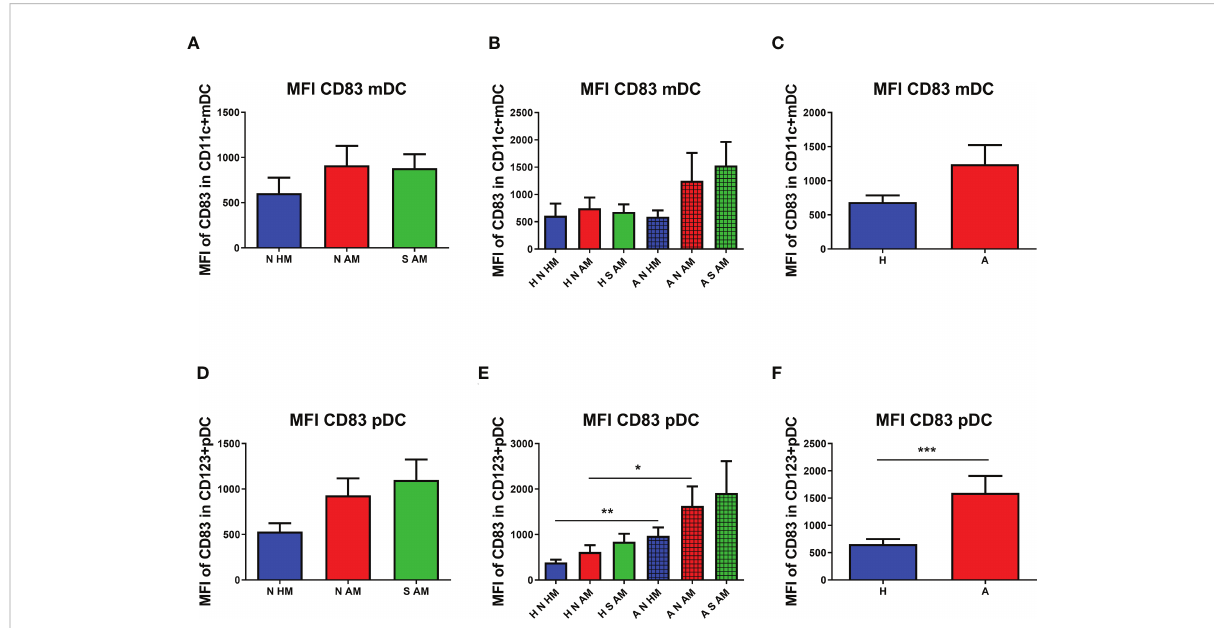
FIGURE 4 Median fl uorescence intensity (MFI) of CD83 on myeloid dendritic cells (mDCs) and plasmacytoid dendritic cells (pDCs). The MFI of CD83 on mDCs of allergic non-supplemented children of healthy mothers (A N HM), allergic non-supplemented children of allergic mothers (A N AM), and allergic E coli O83:K24:H31-supplemented children of allergic mothers (A S AM) is presented in (A) The MFI of CD83+ mDCs in the peripheral blood of children divided according to their allergic status into the six subgroups is documented in (B) Levels of the MFI of CD83 on mDCs of children divided only according to their allergic status are presented in (C) The MFI of CD83+ pDCs of N HM, N AM, and S AM is documented in (D) The MFI of CD83+ pDCs in the peripheral blood of children divided according to their allergic status into the six subgroups is shown in (E) The MFI of CD83 on pDCs of children divided only according to their allergic status is presented in (F) A N HM, allergic non-supplemented children of healthy mothers; A N AM, allergic non- supplemented children of allergic mothers; A S AM, allergic E coli O83:K24:H31-supplemented children of allergic mothers; *p ≤ 0.00167 (adjusted p value); **p ≤ 0.0033 (adjusted p value); ***p ≤ 0.0003 (adjusted p value). H, healthy children regardless of maternal allergy status or Escherichia coli O83:K24:H31 supplementation; A, allergic children regardless of maternal allergy status or Escherichia coli O83:K24:H31